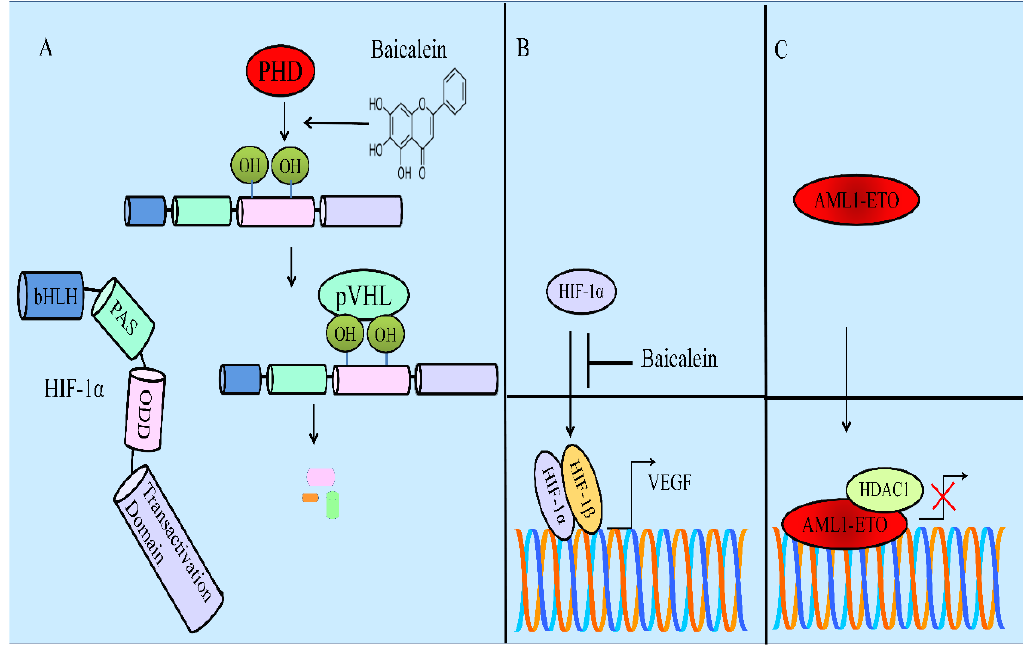
Figure 5. (A) Baicalein induced degradation of HIF-1 α by PHD and pVHL. (B) HIF-1 α and HIF-1 β transcriptionally upregulated VEGF. However, baicalein blocked HIF-1 α -mediated VEGF expression. (C) AML1-ETO worked synchronously with HDAC1 and transcriptionally repressed the target genes.